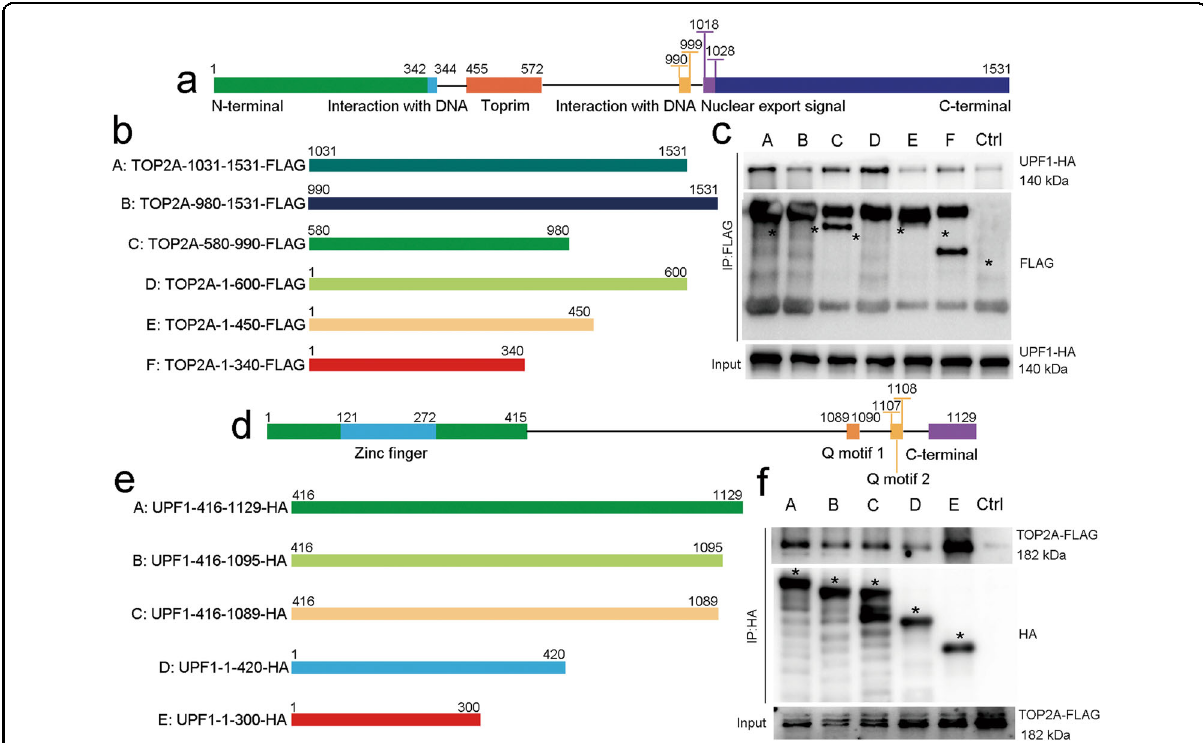
Fig. 5 Co-IP assays using truncated mutants identi fi ed the precise binding region between TOP2A and UPF1. a Schematic diagram of key domains in TOP2A. b Six truncated mutants of TOP2A fused with FLAG tag were generated according to its key domains. c Co-IP assays were performed of the lysates from HEK-293T cells transfected with HA-tagged UPF1 and FLAG-tagged truncated mutants of TOP2A. d Schematic diagram of key domains in UPF1. e Five truncated mutants of UPF1 fused with HA tag were generated according to its key domains. f Co-IP assays were performed of the lysates from HEK-293T cells transfected with FLAG-tagged TOP2A and HA-tagged truncated mutants of